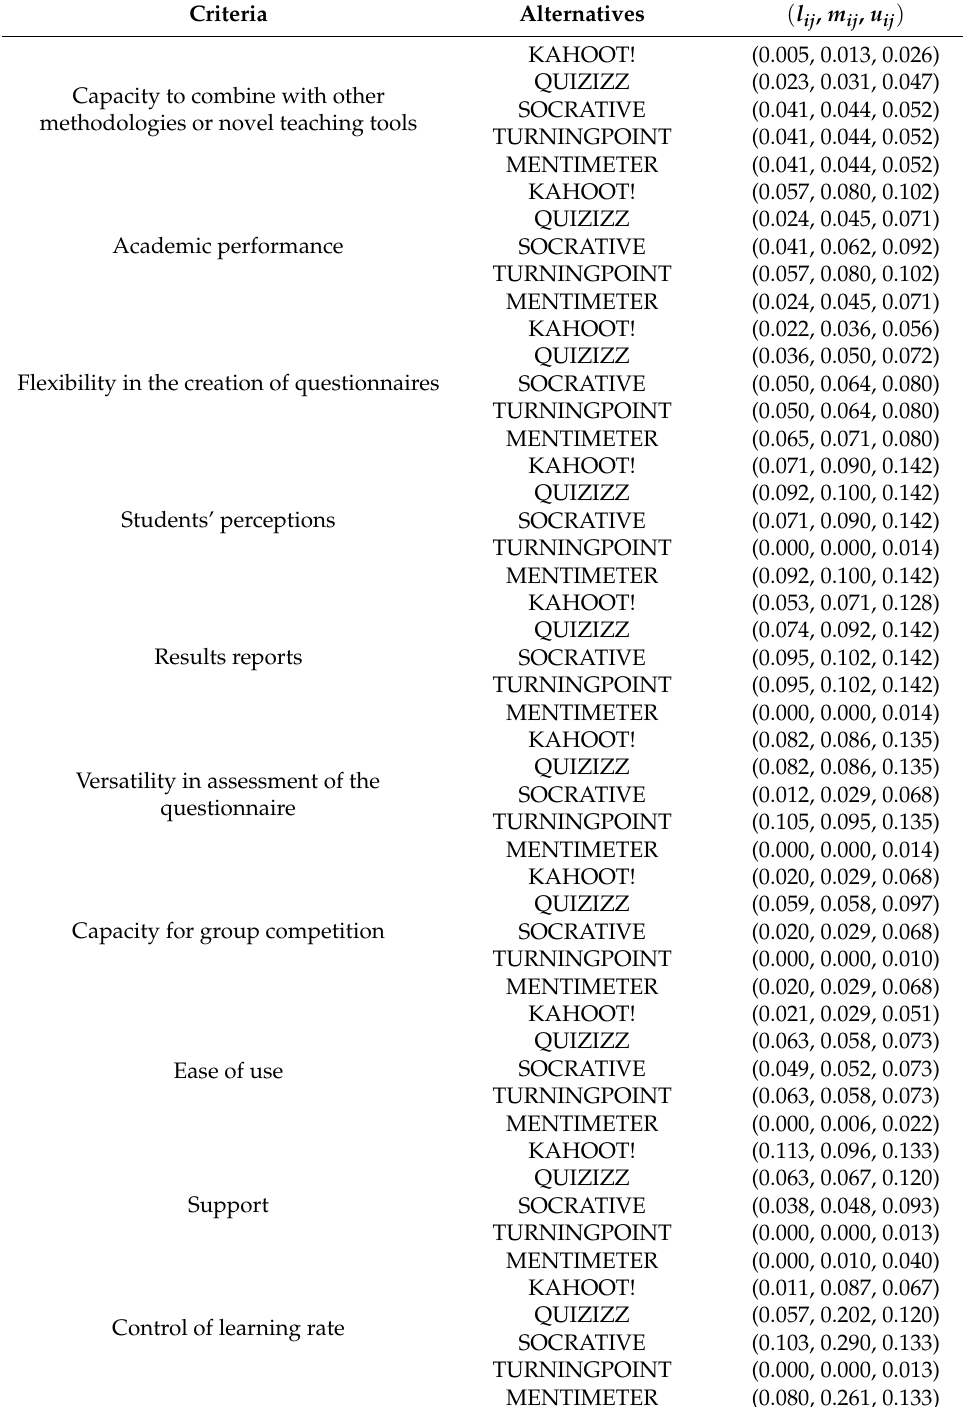
Table 8. Fuzzy weighted normalised decision matrix with W S = 0.5 and W O = 0.5, in the case of objective weights from fuzzy Shannon